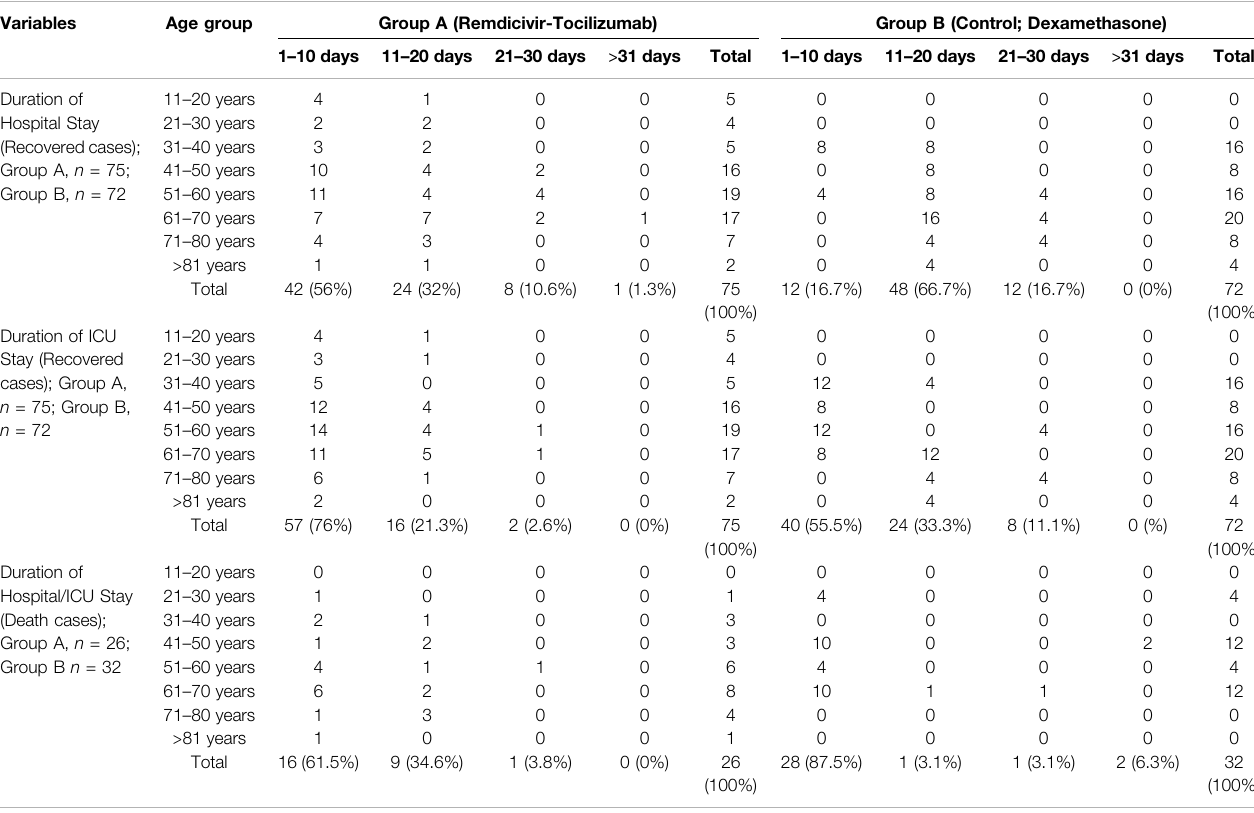
TABLE 5 | Analysis of the recovered and expired COVID-19 cases against recovery duration /death and age. Variables Age group Group A (Remdicivir-Tocilizumab)